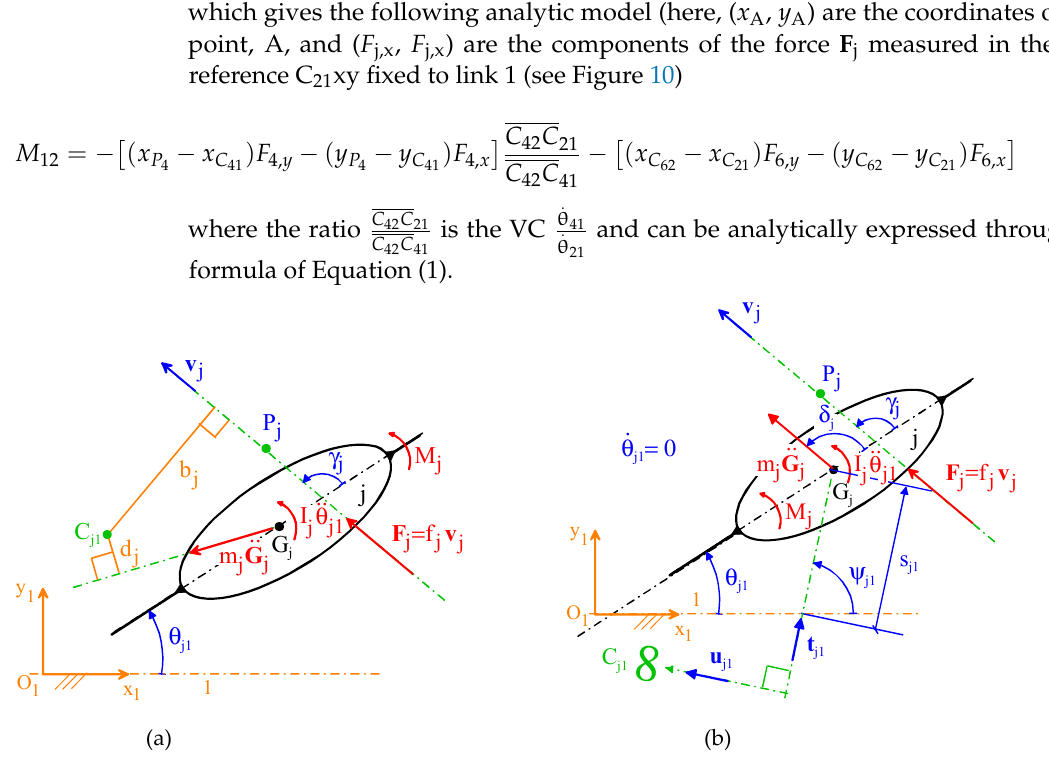
Figure 9. Active-load diagram of the j-th link of a single-DOF PM (link 1 is the frame and O 1×1 y 1 is a Cartesian reference fixed to link 1; F j (M j ) is a generic external force (moment) applied to link j; m j , G j , and I j are mass, barycenter and mass moment of inertia about G j of the j-th link, respectively): ( a ) instantaneous rotation of the j-th link, ( b ) instantaneous translation of the j-th link.